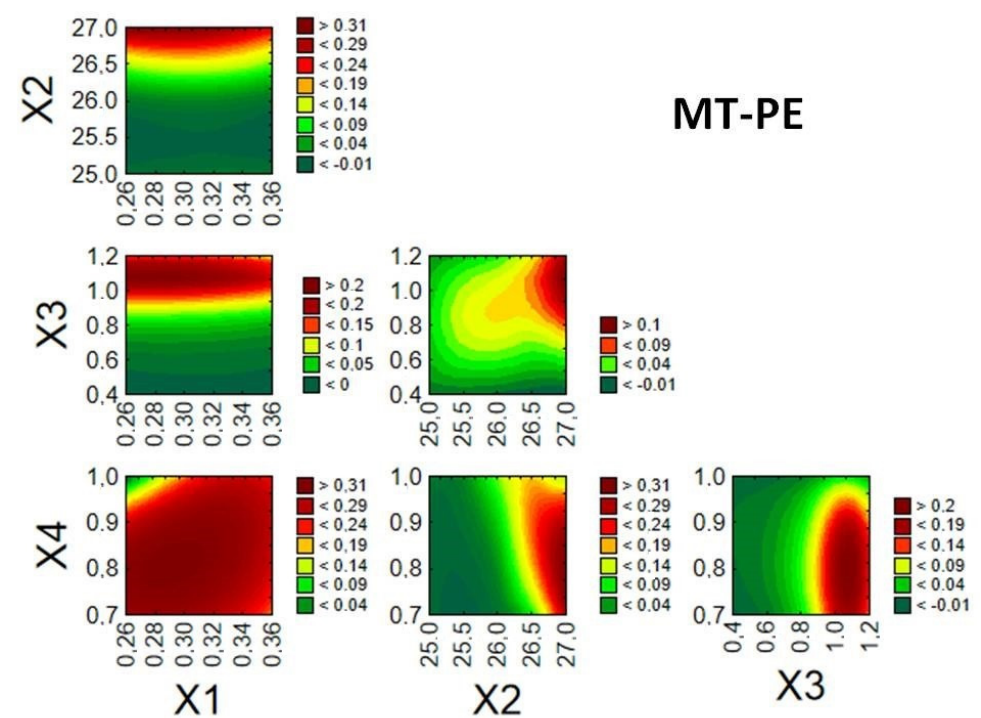
Figure 4. Desirability plots for response surface prediction of MT-PE showing interactions between factors X1–X4.